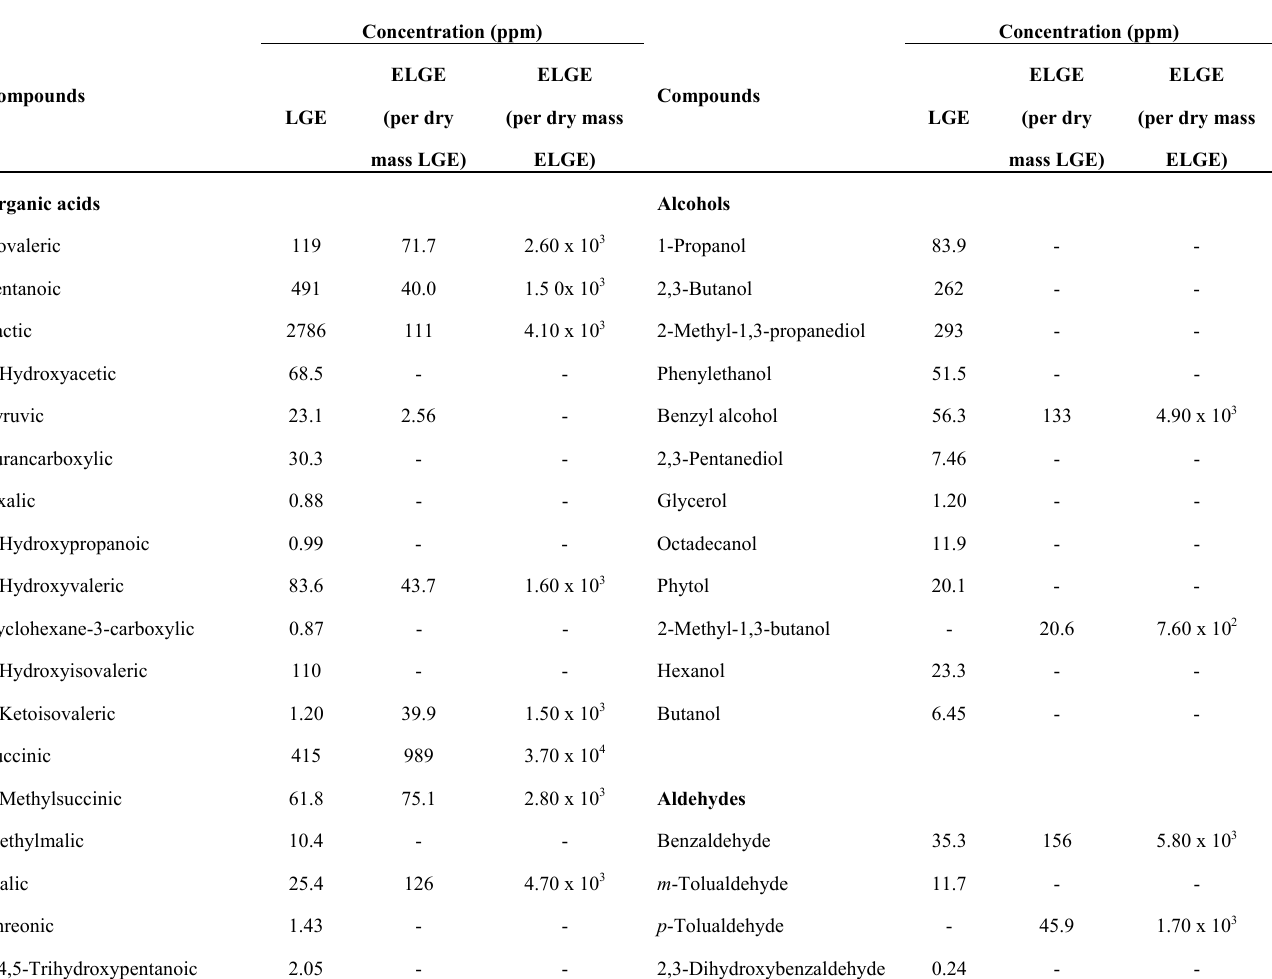
Table 1. Concentrations of GC-MS Identified Compounds from Lyophilized A loe greatheadii var davyana Leaf Gel (LGE) And 95% Aqueous Ethanol Leaf Gel Extracts